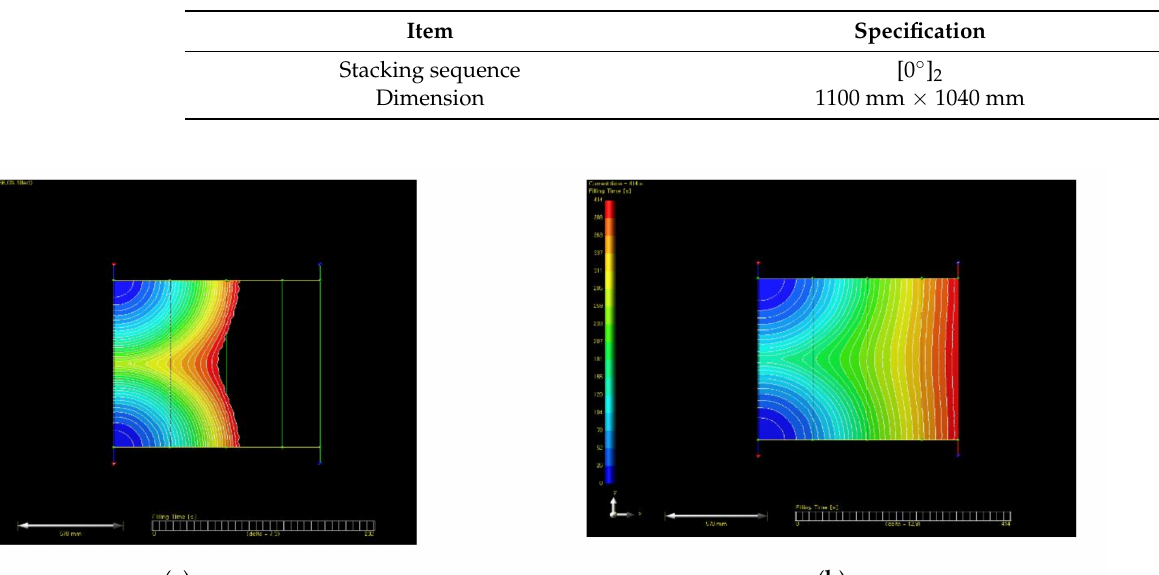
Table 3. Specification of plate structure for simulation.